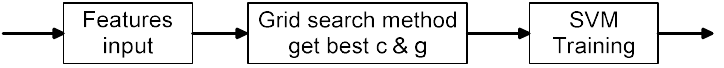
Figure 6. The processing flow of the grid optimized Support Vector Machine (SVM).